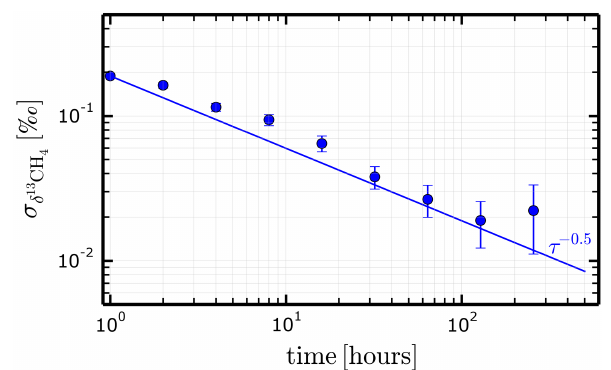
Figure 10. Allan standard deviation of δ 13 CH 4 after correction, us- ing the data in Fig. 16. The τ − 1 / 2 line is shown for reference, indi- cating that the noise is nearly random, at least over 100h. There is a perceptible increase in the Allan standard deviation at about 12h, which may indicate a moderate dependence of δ 13 CH 4 on the di- urnal cycle. The error bars are estimated based upon the averaging time and the time duration of the data